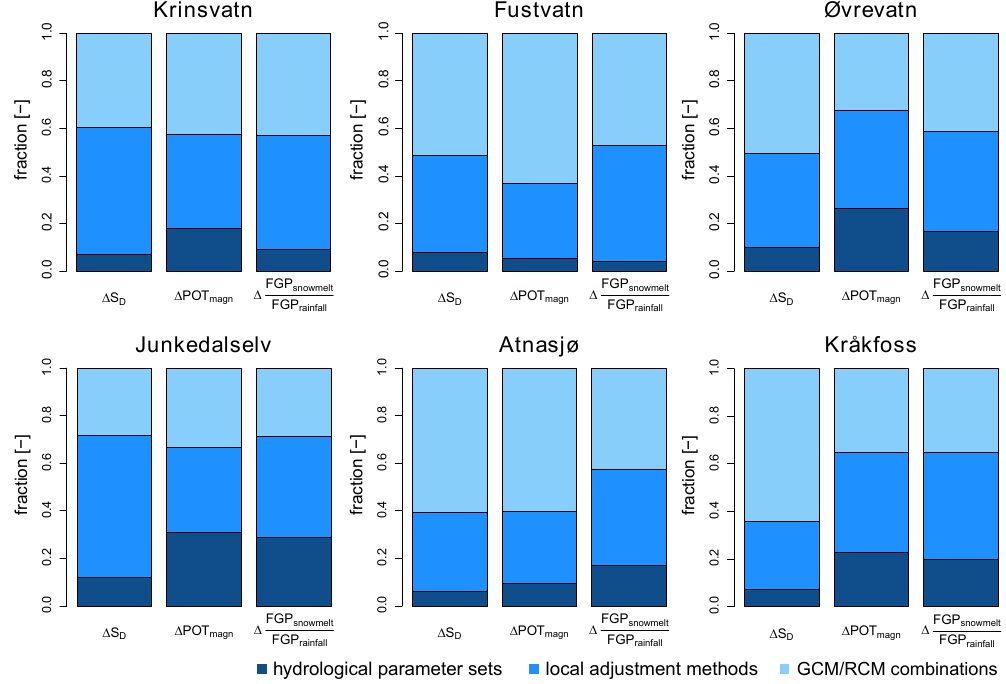
Figure 8. The fractions of total variance (–) as a measure for uncertainty, explained by (i) the GCM/RCM combinations (light blue), (ii) the local adjustment methods (medium blue), and (iii) the hydrological parameterization (dark blue) with respect to three target variables: (1) change in the seasonality index S D , (2) change in the mean POT event magnitude, and (3) change in the ratio of snowmelt- and rainfall- generated POT